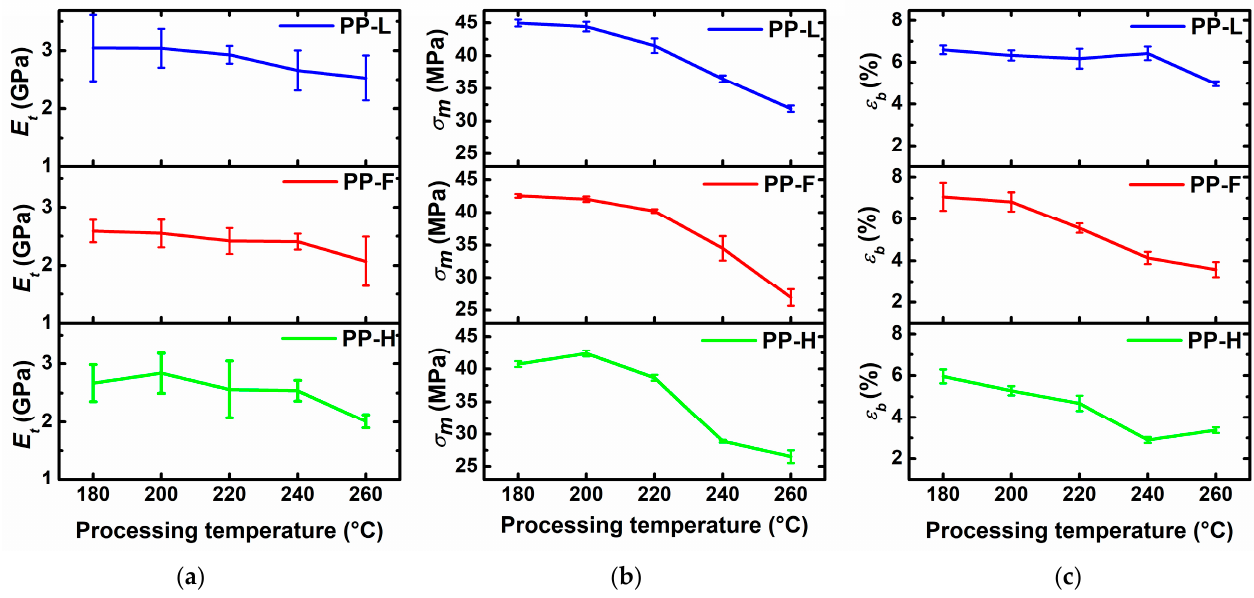
Figure 5. Tensile properties of composites processed at different temperatures: ( a ) tensile modulus; ( b ) tensile strength; ( c ) strain at break.